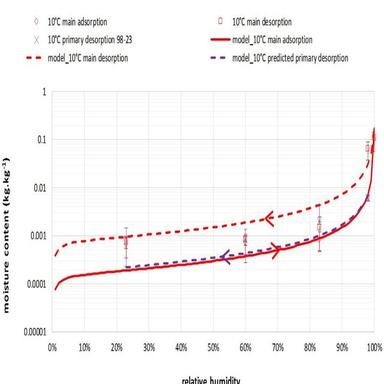
Experimental and modelled primary desorption curve 98–23%RH at 10 C from the Huang model.